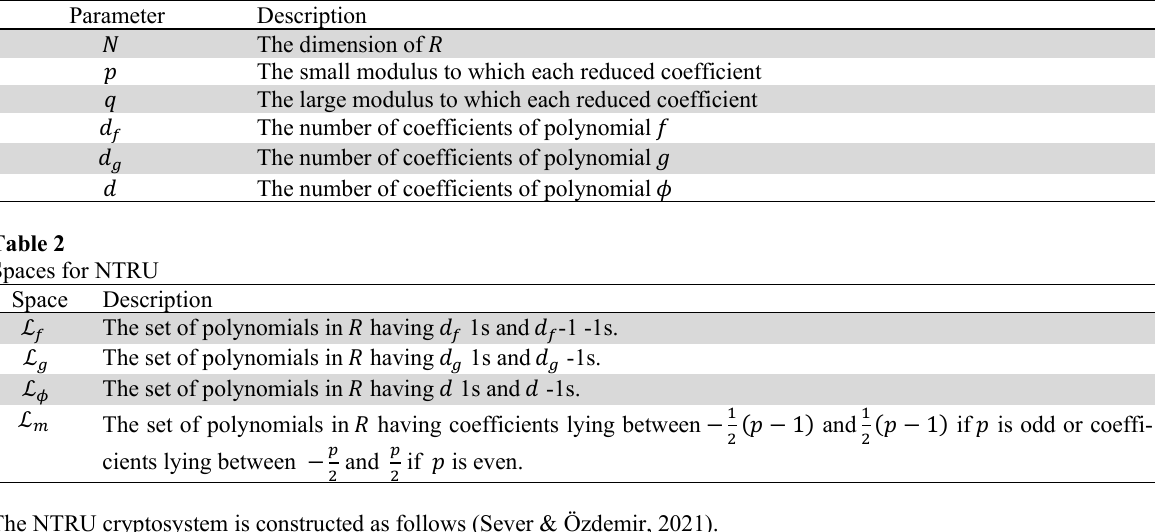
Parameters for NTRU Parameter